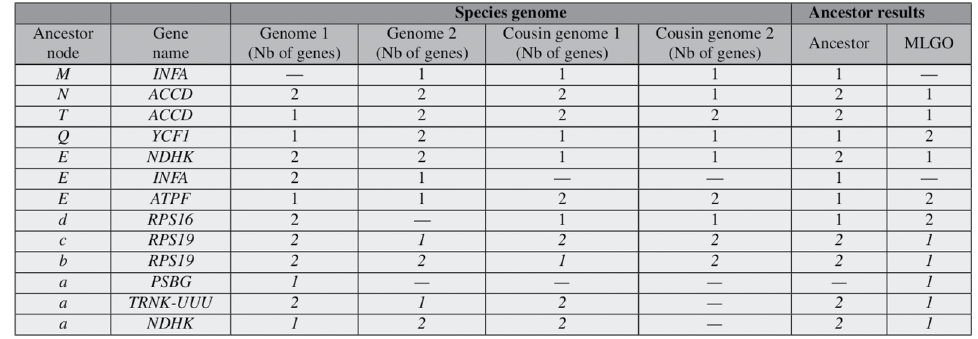
Figure 11: The variation in ancestral genomes nodes which were achieved by comparing our method results with MLGO tool on Fabids